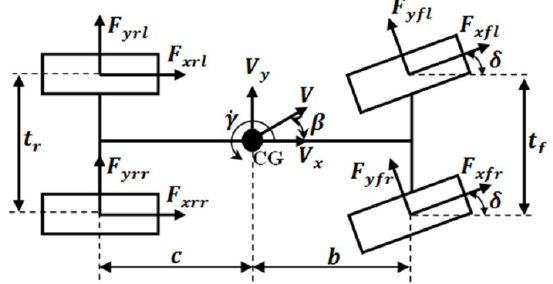
Figure 2: A 3-degree of freedom vehicle handling model free body diagram